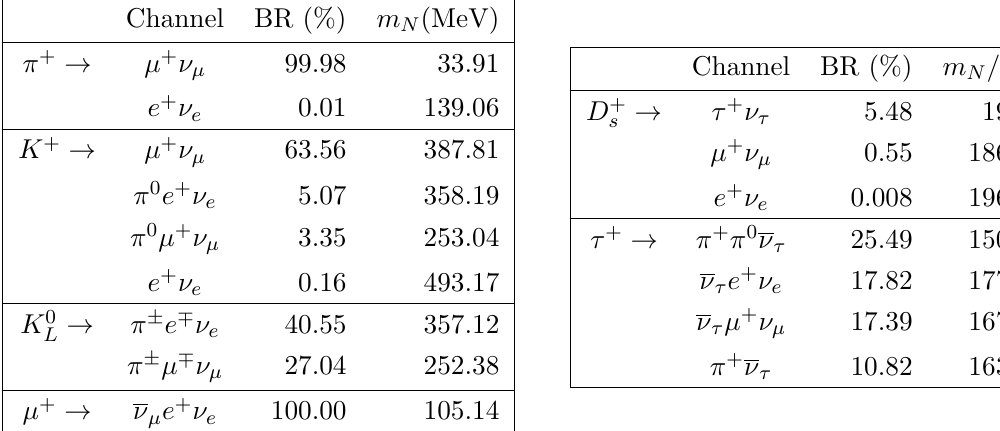
Table 2 . Production channels at beam dump facilities yielding neutrinos, with the respective branching ratios (taken from ref. [111]). The last column shows the maximum neutrino mass allowed if a massive state is produced. On the left, all the decays yielding (cid:23) e , (cid:23) (cid:22) , and (cid:23) (cid:22) up to the K 0 mass are shown. On the right, the neutrino sources which depends on the D + shown; only the (cid:12)rst four decays of the (cid:28) lepton are considered in this